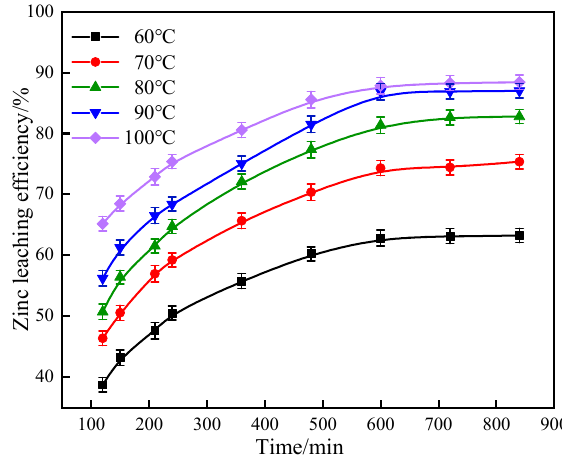
Figure 4. Effect of leaching temperature on zinc leaching efficiency.